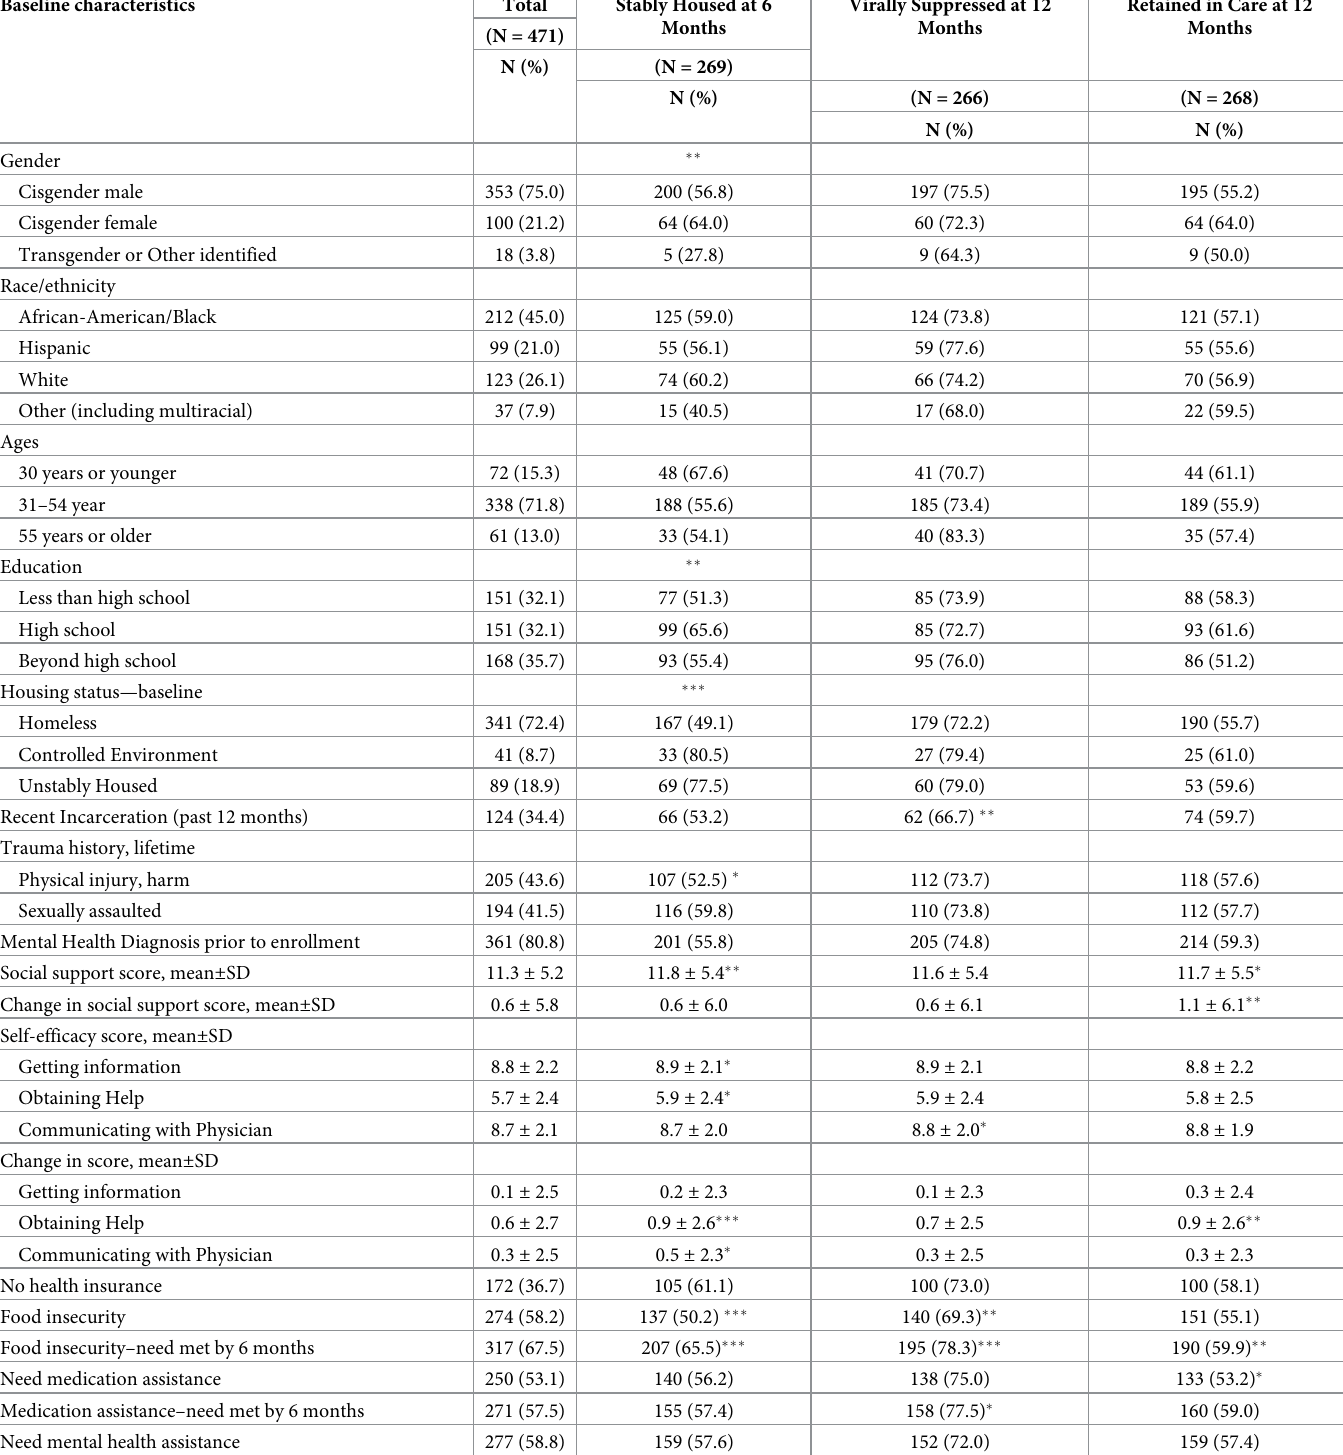
Table 1. Participants characteristics and associations with housing stability and HIV health outcomes, HRSA/SPNS Building a Medical Home for Multiply-Diag- nosed HIV-positive Homeless Populations initiative from 2013–2017. Baseline